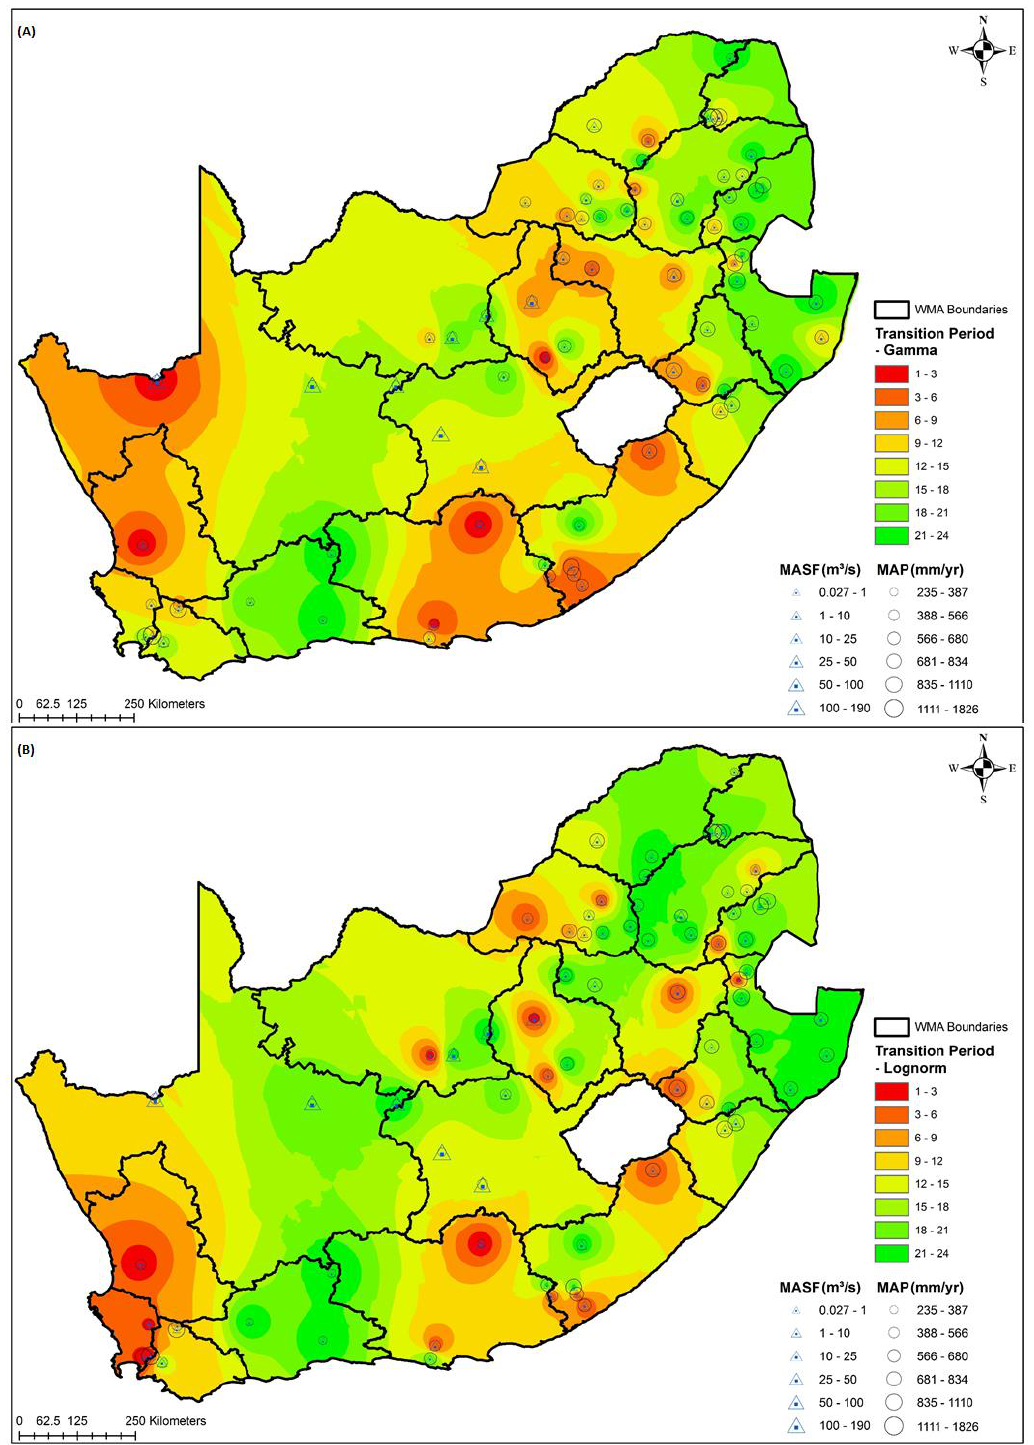
Figure 8. The drought transition period from meteorological to hydrological drought calculated using two-parameter statistical distribution functions ( A ) Gamma and ( B ) Lognormal. two-parameter statistical distribution functions ( A ) Gamma and ( B )